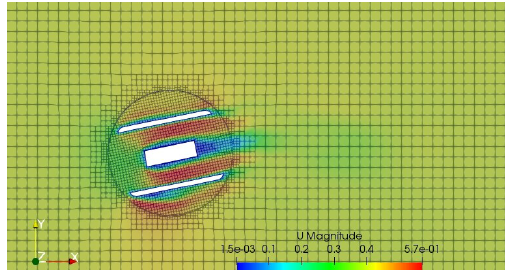
Figure 11. Top view of the instantaneous velocity flow under the yaw motion of the